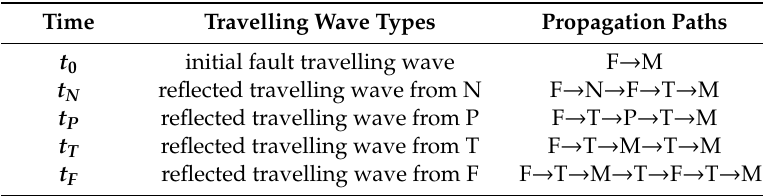
Table 6. Travelling wave types with their reach times.